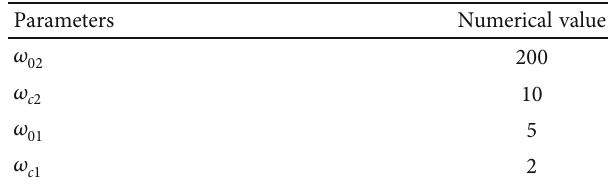
Table 1: Aircraft parameter. Table 2: Control parameter.